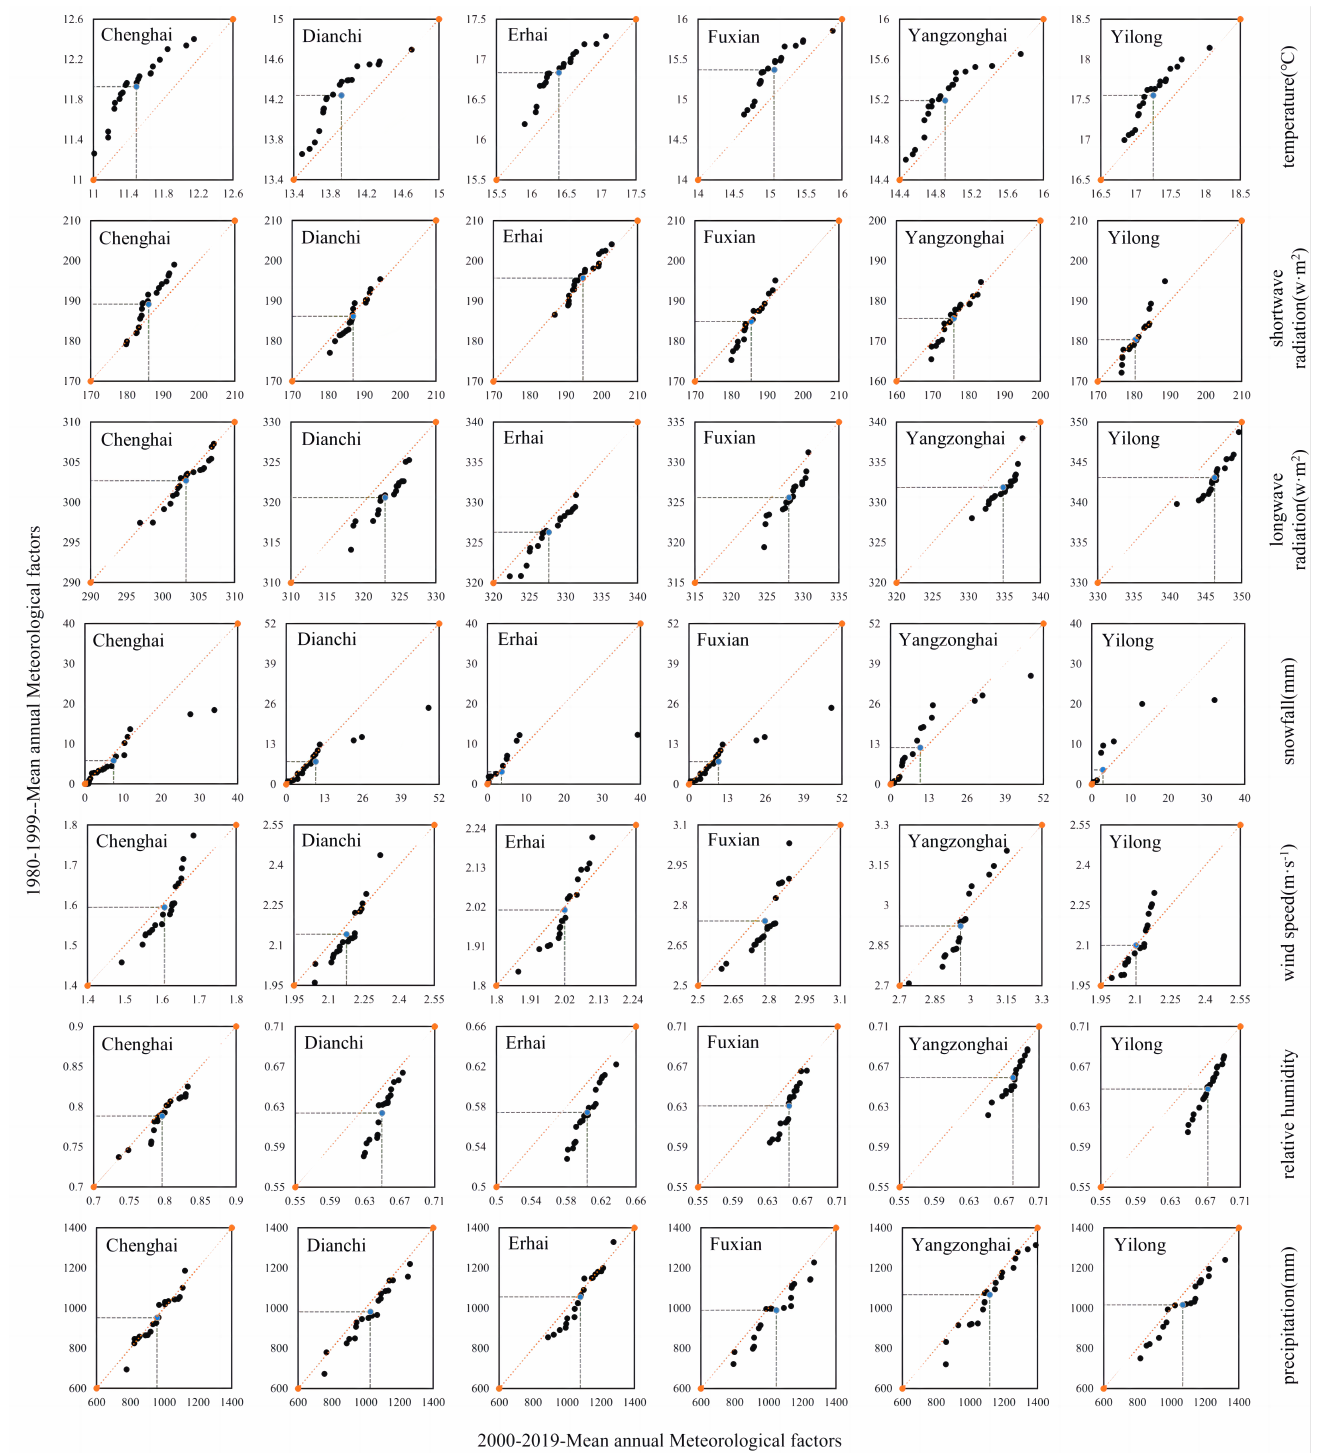
Figure 4. Innovation trend analysis of annual mean value of climatic factors in Yunnan Plateau